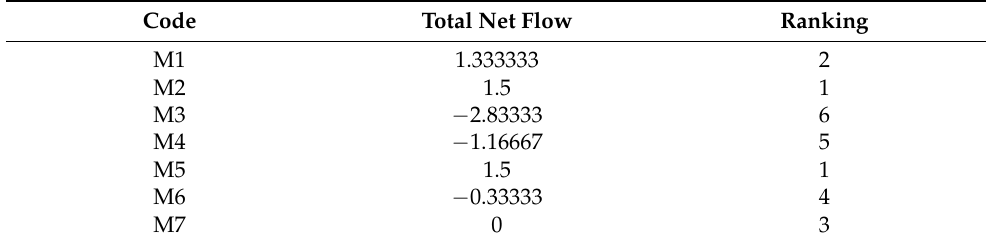
Table 18. PROMETHEE II ranking.